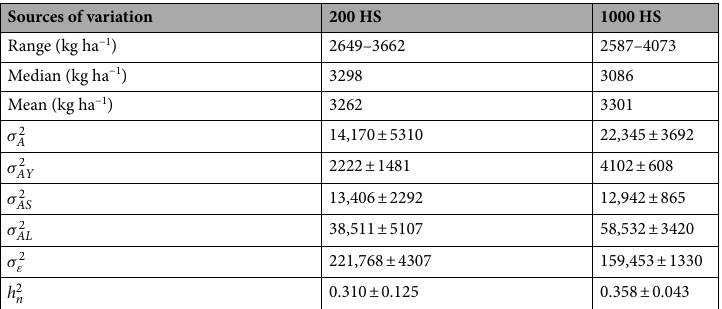
Selection pressure